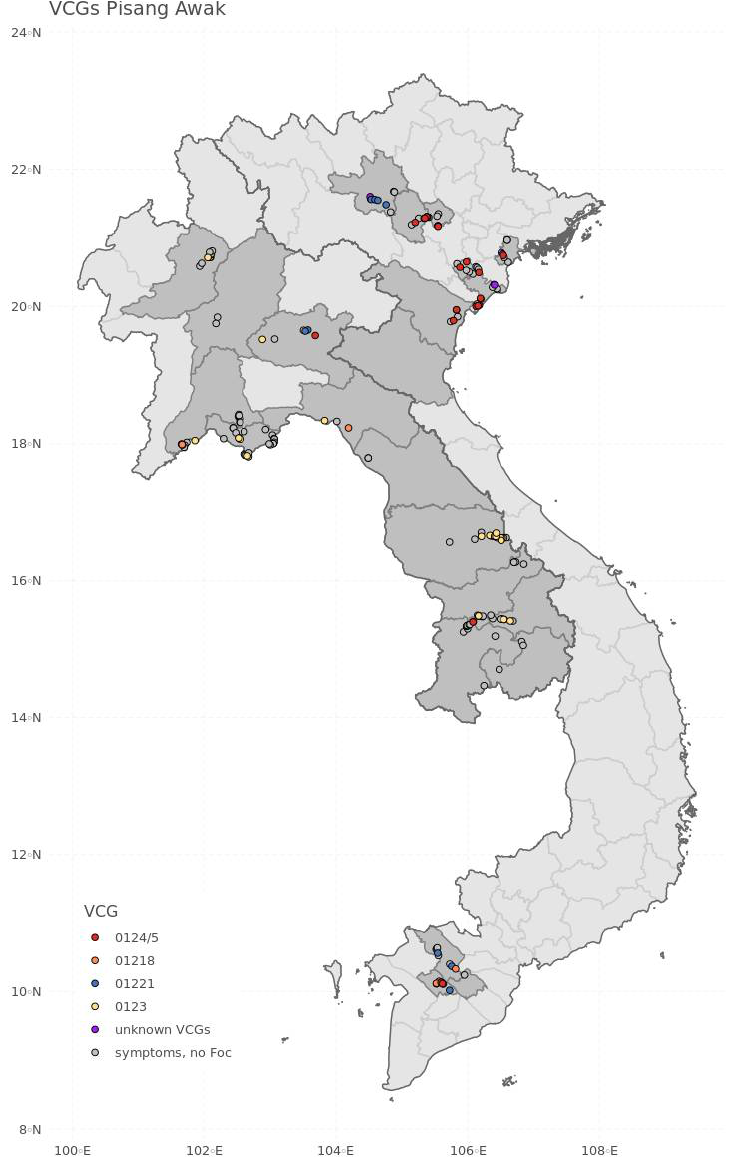
Figure 3. Observations of various VCGs associated with ‘Pisang Awak’. Grey points show ‘Pisang Awak’ fields which showed the traditional symptoms of wilt, but were not identified as fusarium. Red points show fields where VCG 0124/5 was positively identified; yellow points where VCG 0123 was identified; blue points where VCG 01221 was identified; orange points where VCG 01218 was identified.